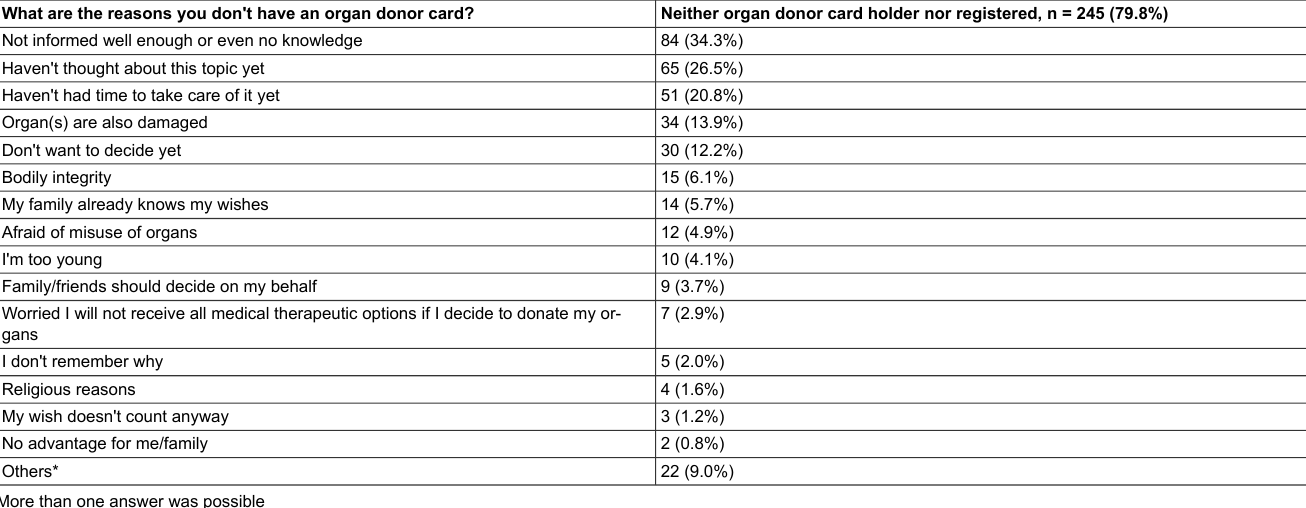
Table 4: Reasons for neither having an organ donor card nor being